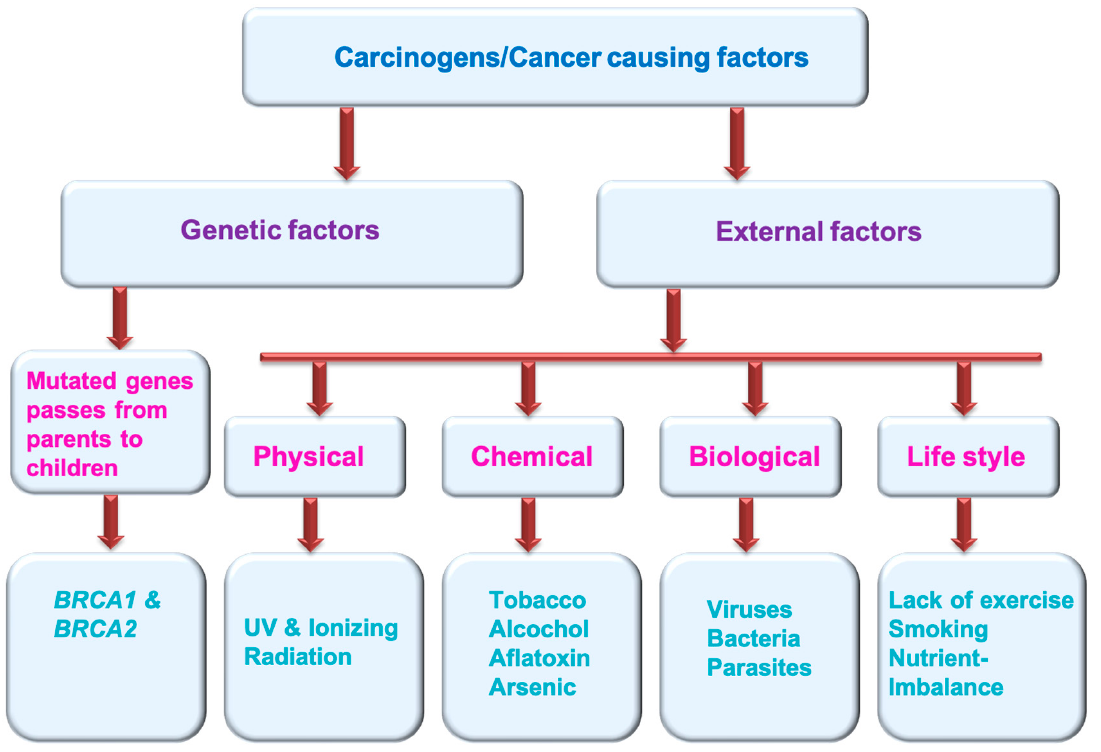
Figure 1. Cancer causing